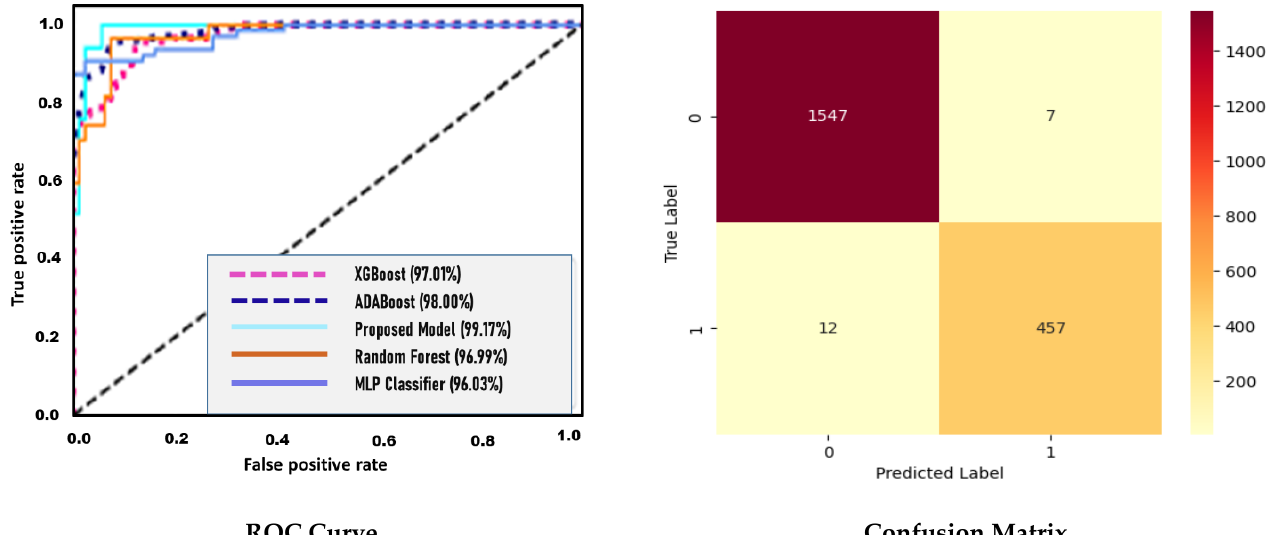
Figure 10. Confusion matrix for proposed algorithm after hyperparameter tuning and